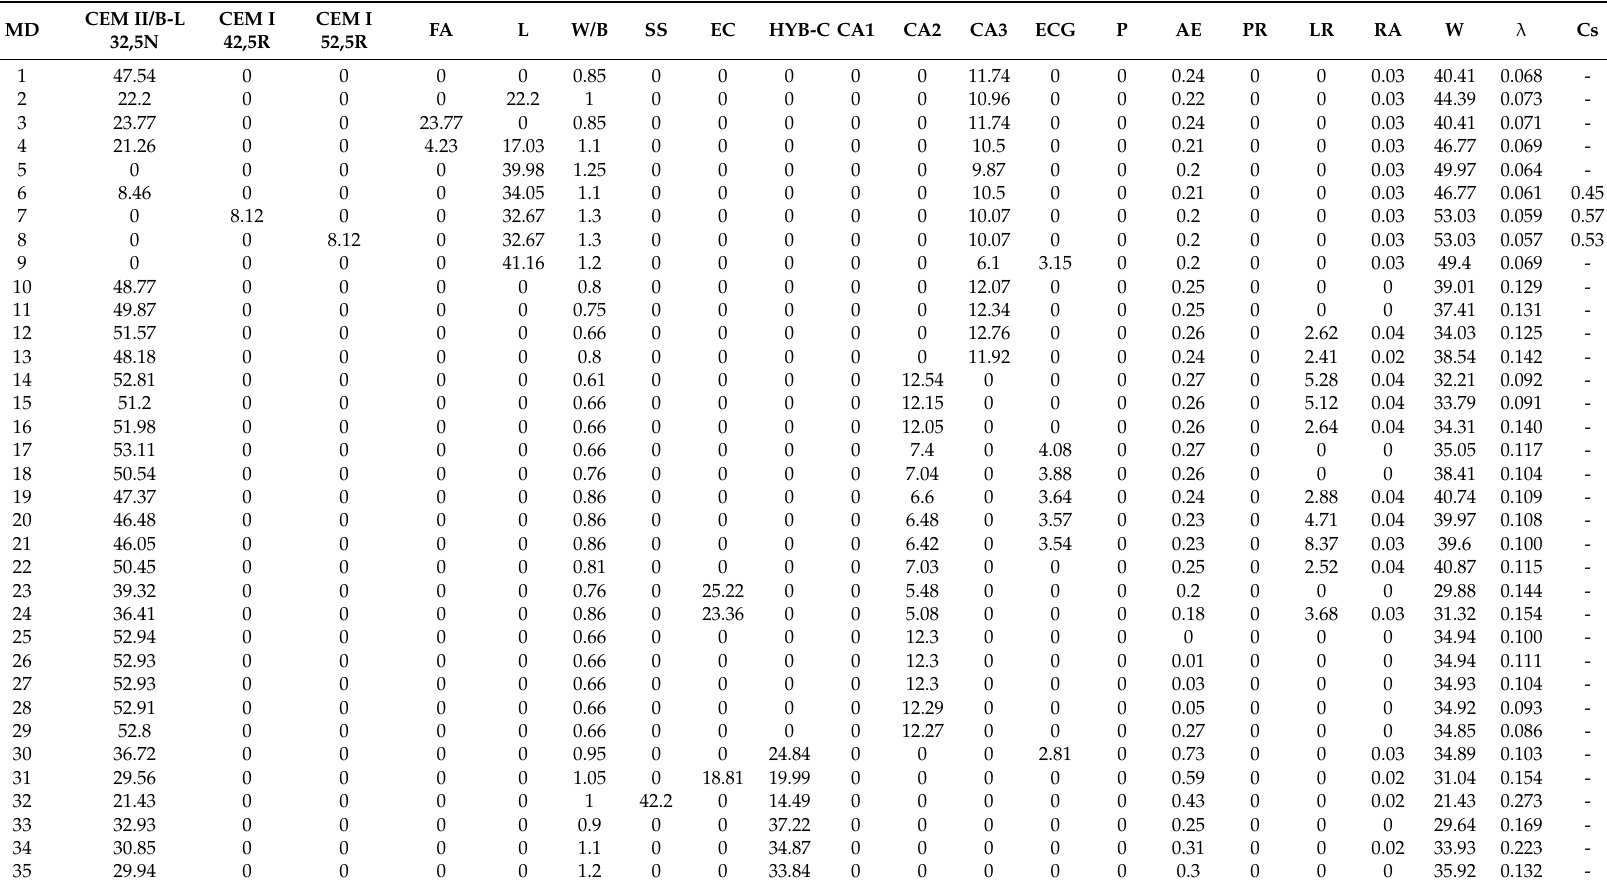
Table A1. Mortar compositions (%wt.); water/binder ratio; tests at 28